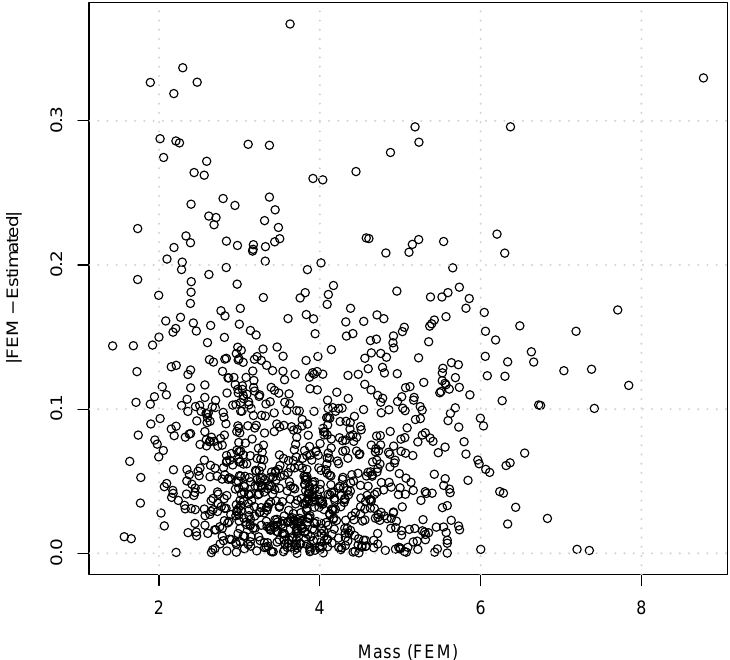
Figure 11. Mass values computed by FE and the metamodel.